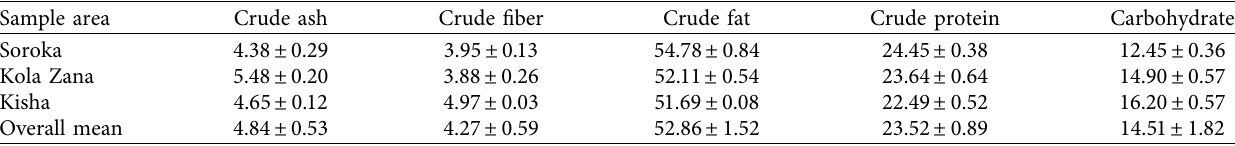
Table 2: Proximate composition (%w/w dry weight) of sesame seeds from three diferent cultivation areas of Tsegede, Ethiopia Sample area